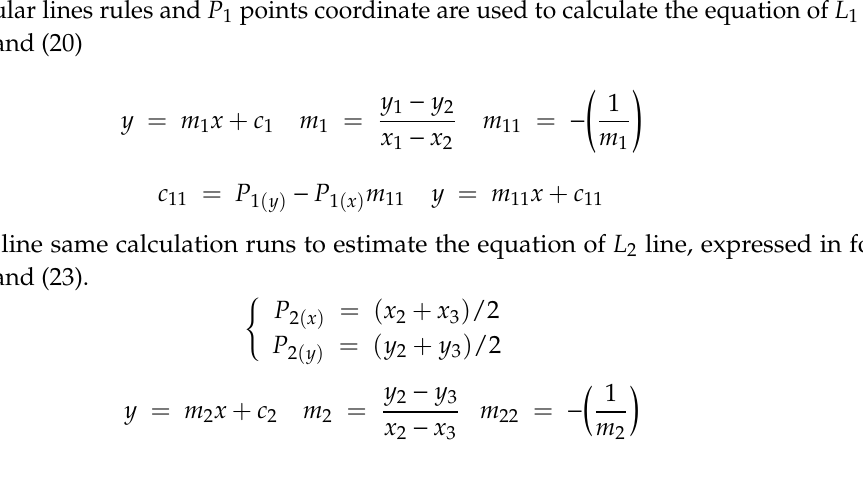
Figure 6. Relationship between “ a ” parameter and road turning.